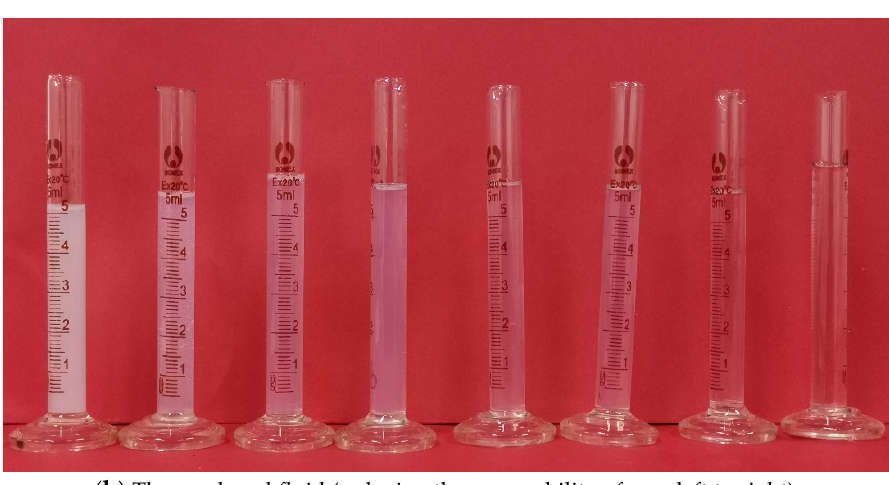
( b ) The produced fluid (reducing the permeability of core left to right). Figure 7. The experiment results of matching between SMG-mm − and reservoir. Figure 7. The experiment results of matching between SMG-mm − and